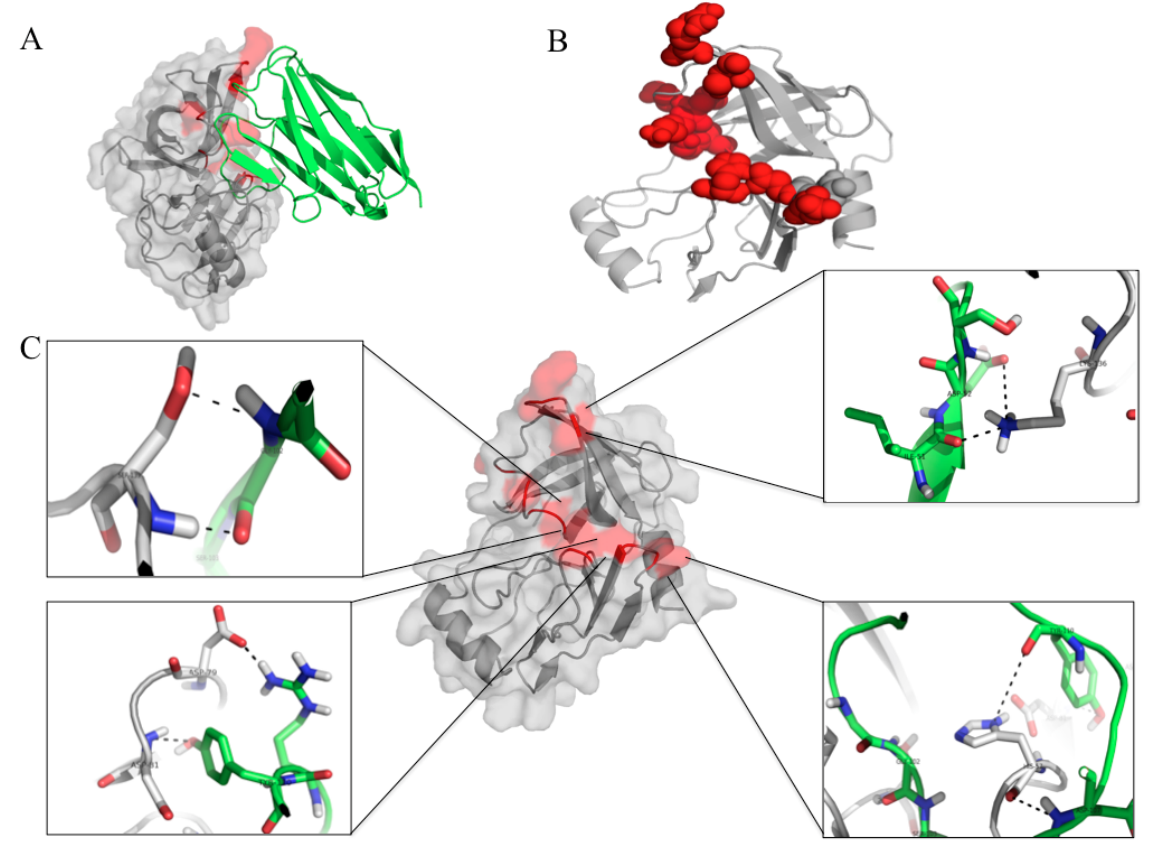
Figure 9. The molecular interaction between the HCV NS3/4A protease and the protease specific-V H H24. ( A ) and ( B ) The nanobody (green in A) uses CDRs 2 and 3 in binding to spatially juxtaposed areas of the folded protease molecule (red). ( C ) Details of the interactive amino acid residues of the nanobody (green) and the NS3 protein (grey) (see also Table 1A). Binding of the V H H28 to the HCV NS3/4A are illustrated in Figure 10A–C. The V H H28 interacted with many residues of the HCV protein. Among them were H57/H1089 and D81/D1113 of the catalytic triads and L135 of the S1 site. Figure 10C and Table 1B give details on the interactive residues of NS3/polyprotein of HCV genotype 3a with the V H